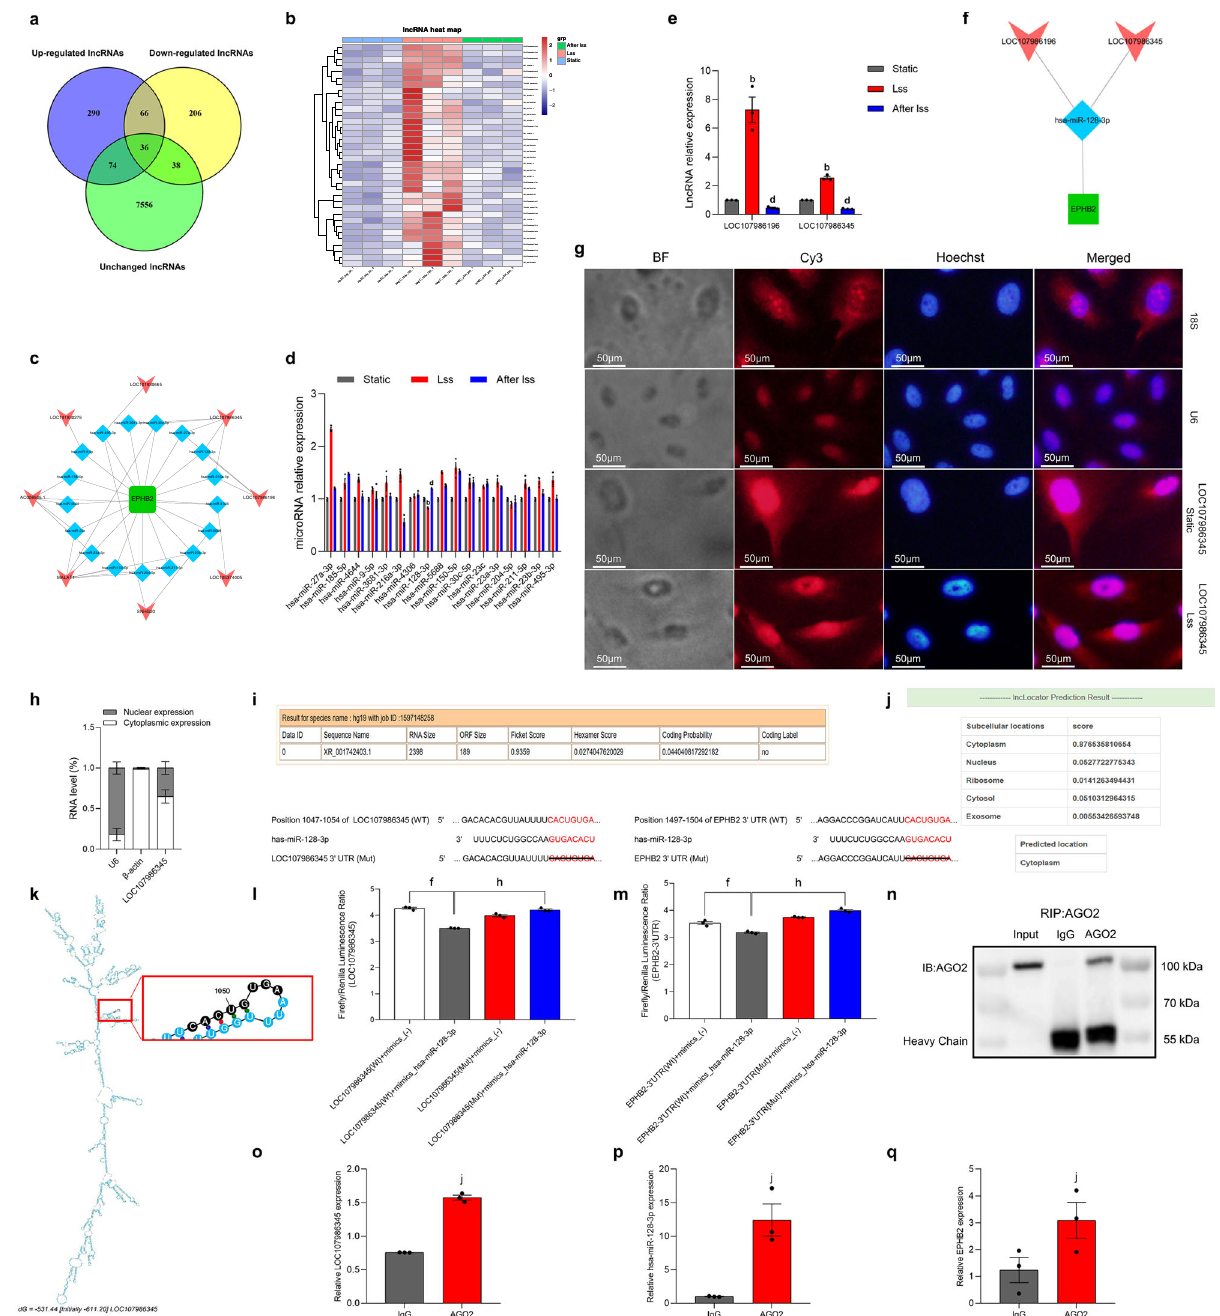
Fig. 5 Construction of the LSS-related LOC107986345/miR-128-3p/EPHB2 network. a DE lncRNA Venn diagram. b DE lncRNA heat map. c ceRNA network regulation diagram with EPHB2 as the core. d qRT-PCR shows the expression of 17 miRNAs. e qRT-PCR shows the expression of LOC107986345 and LOC107986196. f Construction of the LOC107986345/miR-128-3p/EPHB2 and LOC107986196/miR-128-3p/EPHB2 networks. g The FISH experiment shows the subcellular localization of LOC107986345 under a laser confocal microscope. 18S and U6 were used as internal controls. Cy3 label shows LOC107986345 labeled with lncRNA FISH probe and internal control (red), and Hoechst staining shows the cell nucleus (blue). h qRT-PCR shows the subcellular localization of LOC107986345. U6 was used as the nuclear gene reference, and β -actin was used as the cytoplasmic gene reference. i CPAT predicts the coding ability of LOC107986345. j LncLocator predicts the subcellular localization of LOC107986345. k Mfold web server predicts the secondary structure of LOC107986345. l Luciferase reporter gene experiment shows the targeting relationship between LOC107986345 and miR-128-3p. m Luciferase reporter gene experiment shows the targeting relationship between EPHB2 and miR-128-3p. n – q . Anti-AGO2 RIP assay shows the amounts of LOC107986345, miR-128-3p and EPHB2 in anti-AGO2 and anti-IgG immunoprecipitates. Data are presented as mean ± SEM of three independent